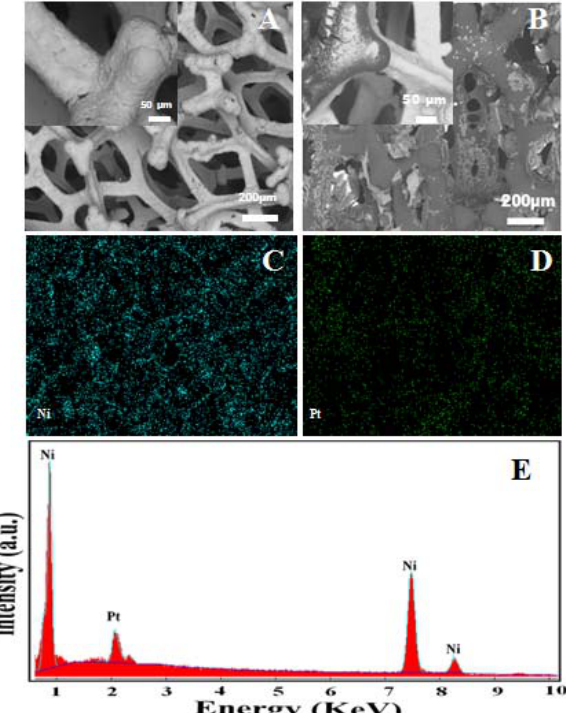
Figure 1. ( A ) SEM image of bare Ni foam; ( B ) Hb-modified Ni foam. The insets of (A) and (B) show the highly magnified image of bare Ni foam and hemoglobin-modified Ni foam with covered and non-covered surfaces. ( C ) EDX mapping of the Ni and ( D ) Pt atoms. ( E ) EDX spectrum of the Ni